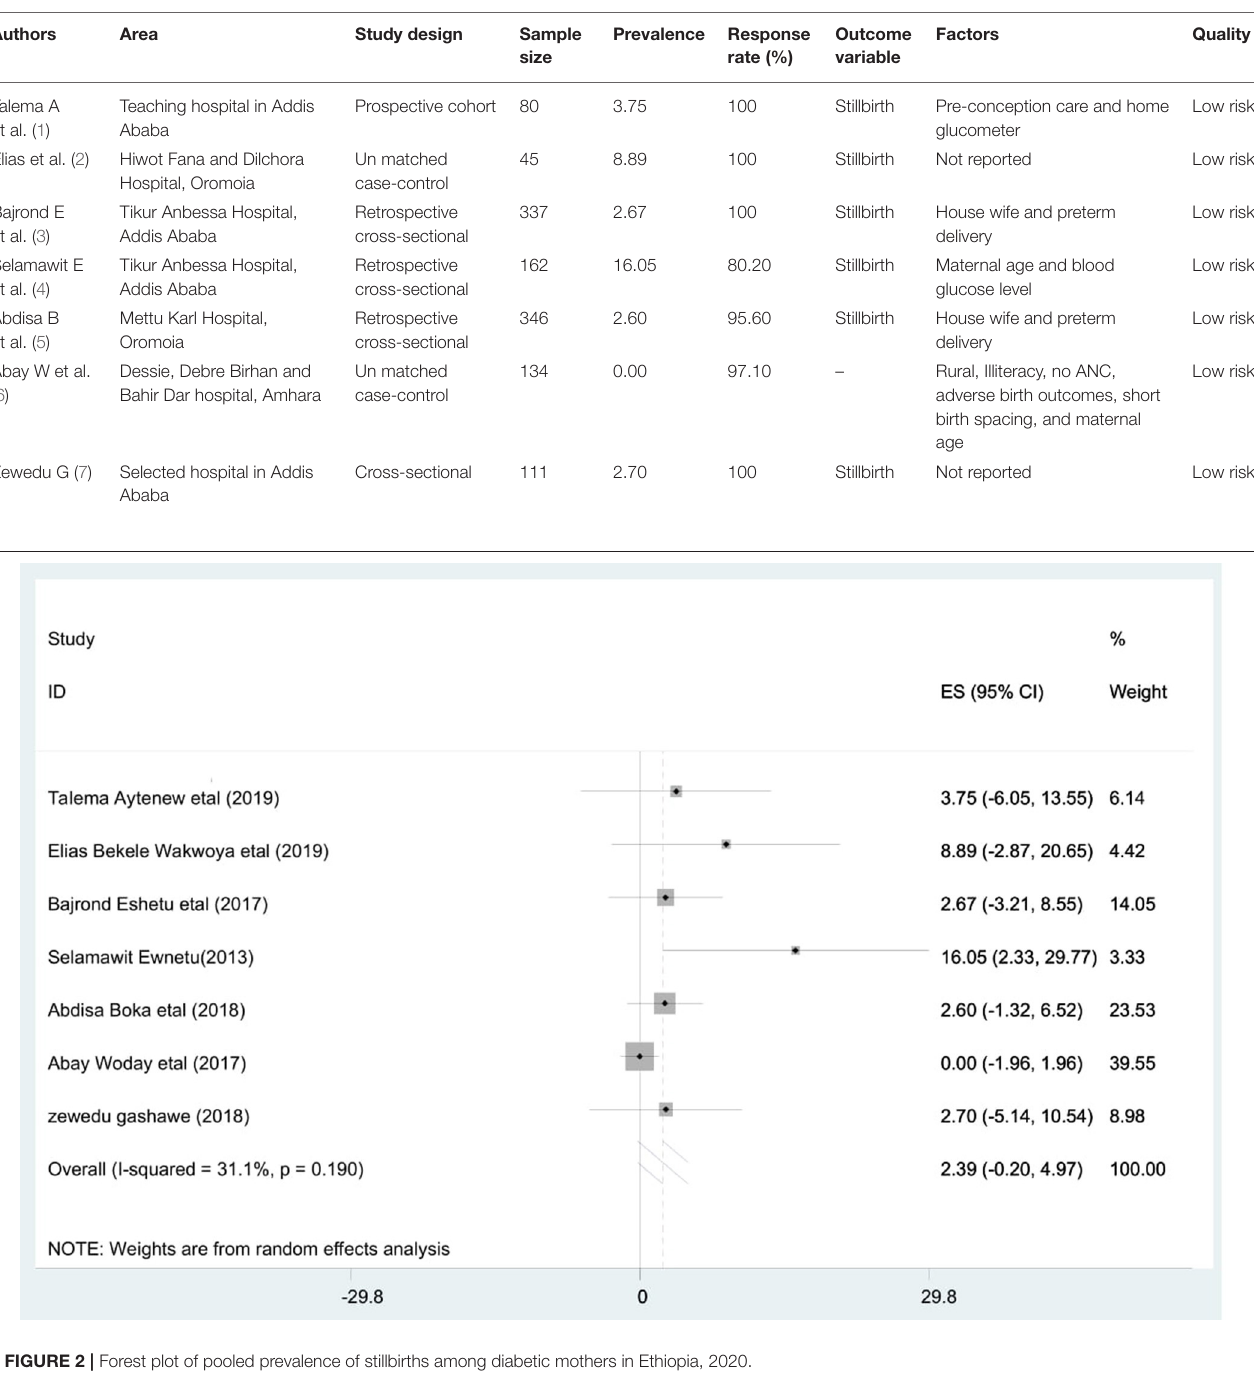
to a similar healthcare package and system toward maternal and newborn health service between